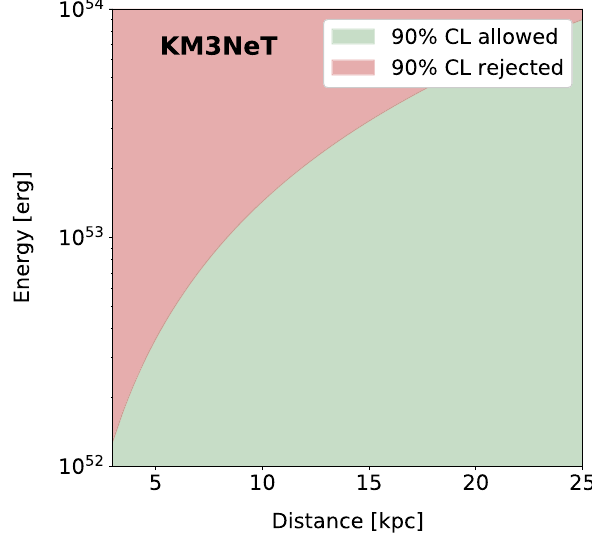
Fig. 9 Exclusion region at 90% CL for total released energy versus CCSN candidate distance for the followup of S200114f, determined by an upper limit of μ s , 0 . 9 = 4 . 8 against an expectation value of μ s (cid:4) 5 for the considered spectral parameters at a distance to the progenitor of 10